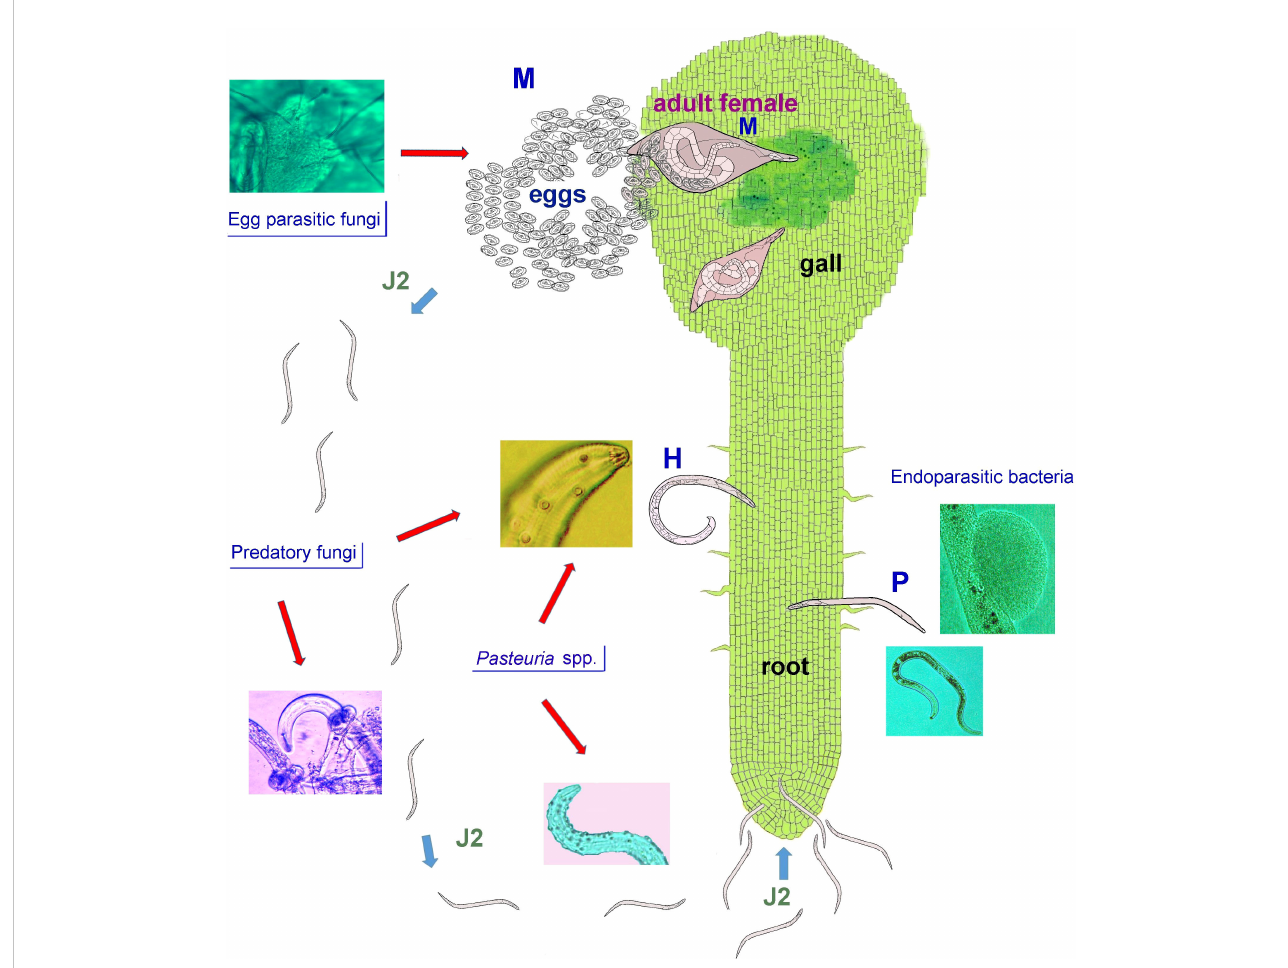
FIGURE 1 A schematic representation of a generic tri-trophic food web showing most common types of plant-parasitic nematode (PPN) antagonists, occurring in the rhizosphere environment. Three PPN with different lifestyles and trophic behaviour are shown: a sedentary root-knot nematode (RKN, M), Meloidogyne sp. ; a migratory ectoparasite, such as the spiral nematode Helicotylenchus sp. (H), and a migratory endoparasite, Pratylenchus sp. (P). A number of fungi parasitize RKN eggs in soil or in colonized egg masses. The RKN second stage juveniles (J2), emerging from the remaining healthy eggs, migrate in soil toward the root apex. During this limited time period the J2 may encounter traps of other predatory fungi and/or infective propagules of bacterial endoparasites, i.e. Pasteuria spp. Once inside the roots, the J2 induce histological alterations yielding a root swelling (gall) with a feeding site, allowing the immature females development and adults reproduction. At this stage Pasteuria spp. complete their life-cycle in synchronism with the host and digest its body content, before being released in the rhizosphere environment (not shown). Also ecto- and endoparasitic nematodes are exposed in soil to fungal predators and/or to infection by bacteria, including other host-speci fi c Pasteuria spp. and several unclassi fi ed